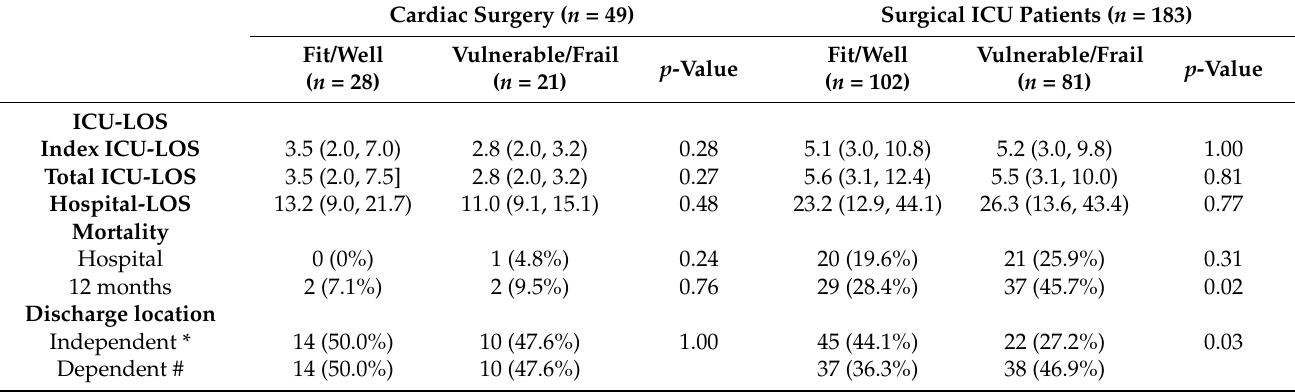
Table 3. Influence of frailty on patient outcome—comparison cardiac surgery versus non-cardiac surgery/surgical ICU patients, Abbreviations: LOS-Length of stay; ICU-Intensive Care Unit, * Independent = home + rehabilitation, # Dependent = hospital, long-term- and palliative care). Cardiac Surgery ( n =